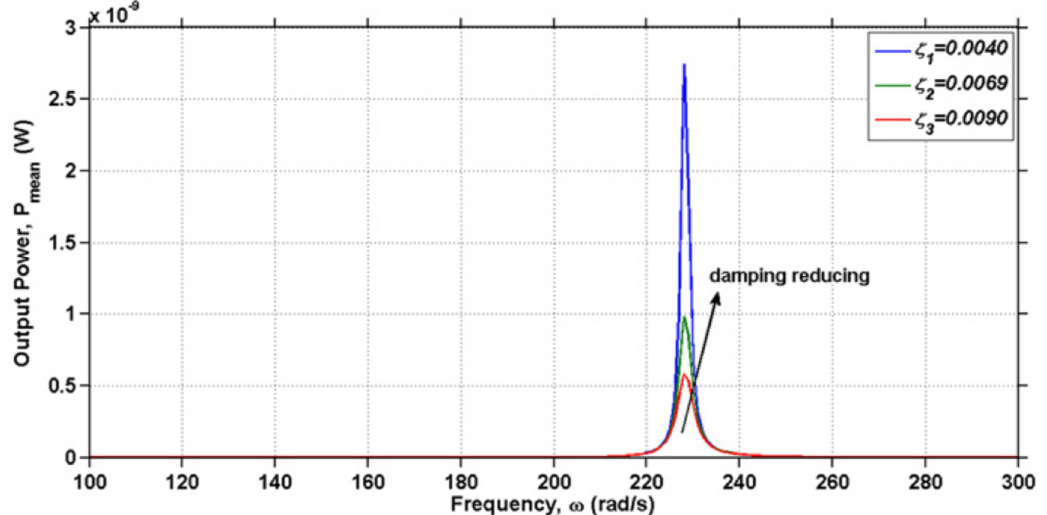
Figure 15. Mean power output of the EAPap‐based energy harvester for a range of frequencies in different damping ratios [79].